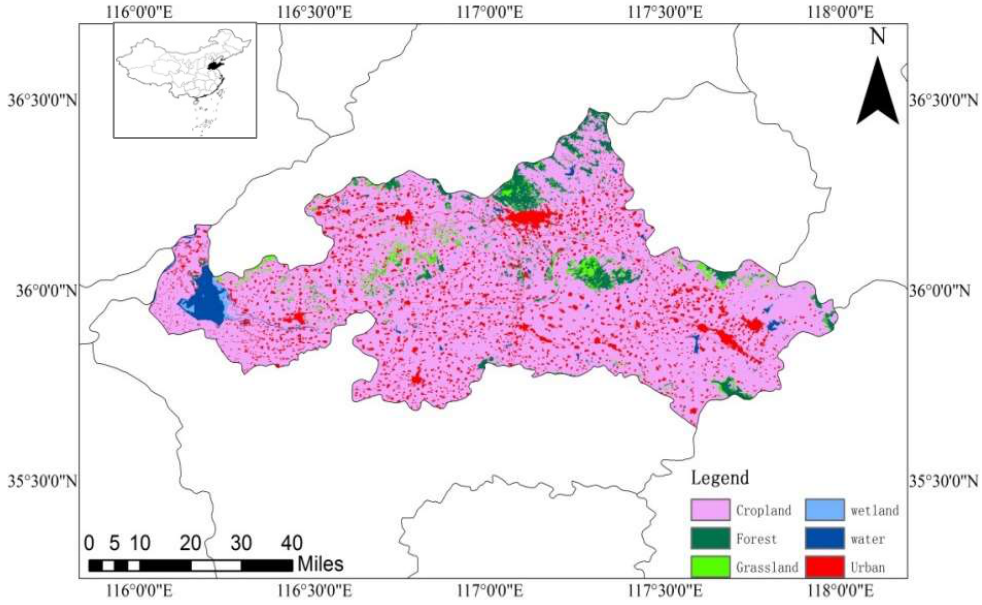
Figure 8. Location of the study area, showing the land cover classification from Globeland30 2010.